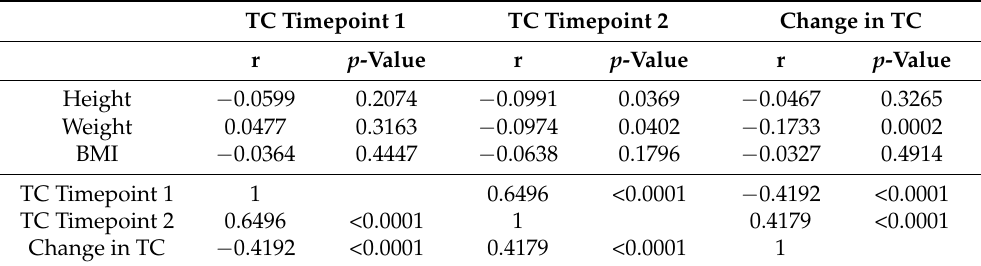
Table 5. Correlation between cholesterol levels/changes and continuous growth- and weight- related variables.